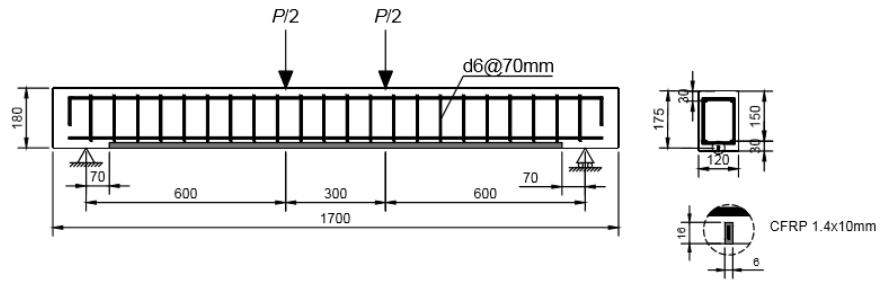
Figure 1. Experimental beam—geometry and reinforcement.